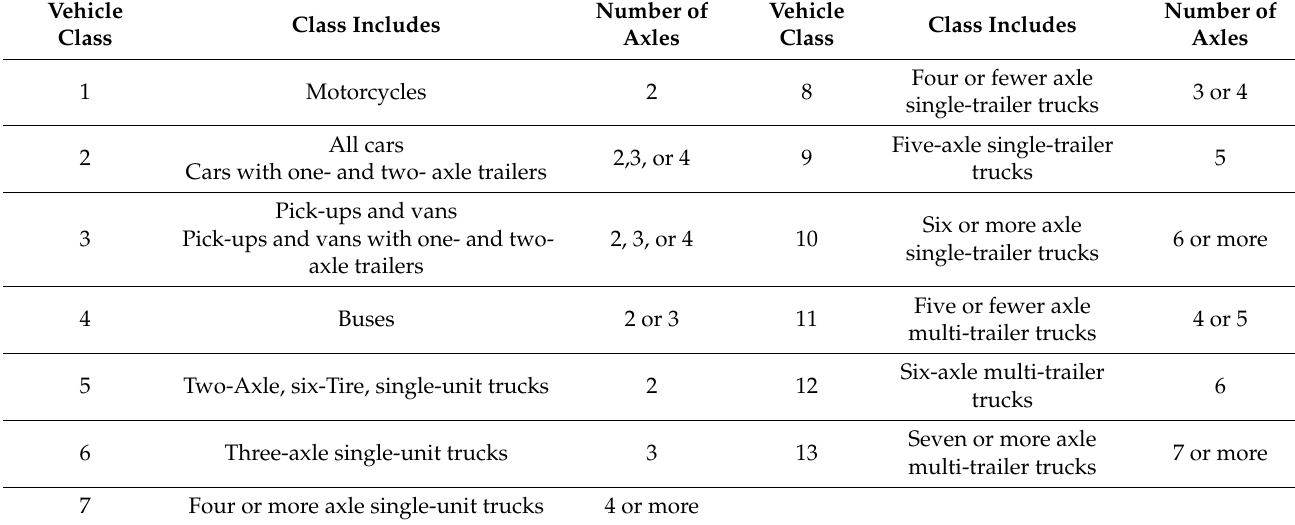
Table 1. This is a table. FHWA vehicle classification